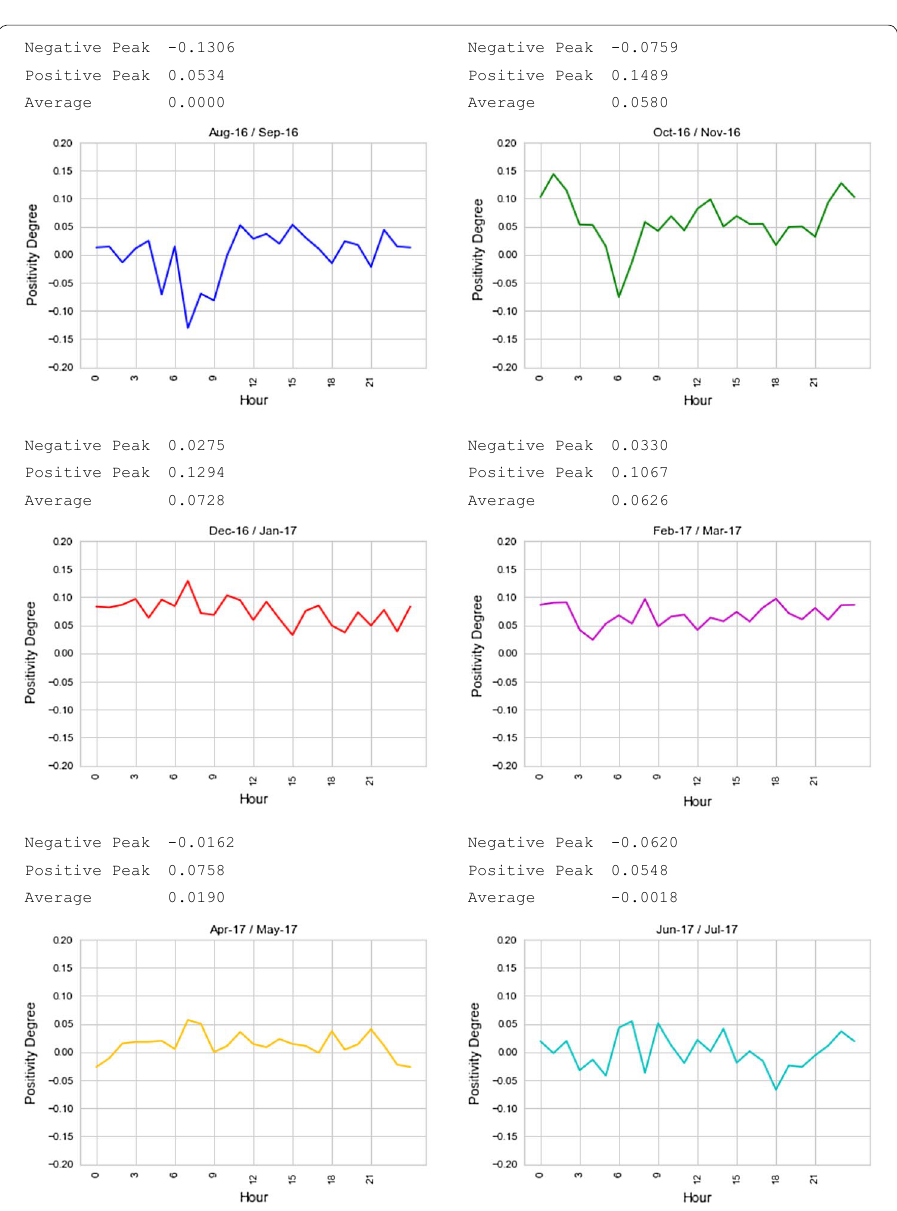
Fig. 2 Sentiment variation by time/bimester (Source: prepared by the